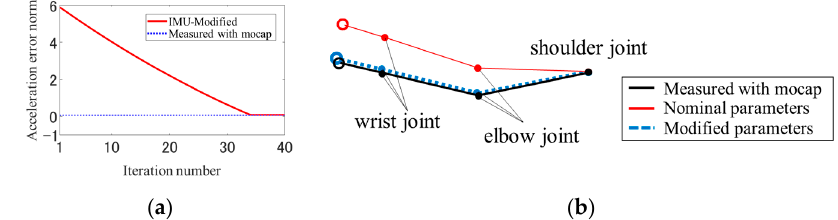
Figure 3. ( a ) Acceleration error norm due to the values measured with mocap and the output value of the IMU by repeated calculation at the wrist joint; ( b ) initial orientation stick picture of the values measured with mocap, IMU-nominal, and IMU-modified in the coronal